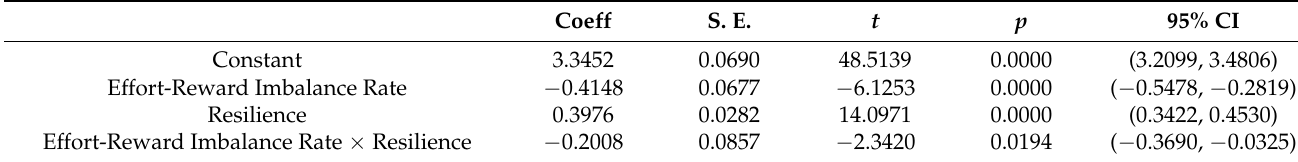
Table 4. Analysis of the moderating effect of resilience.